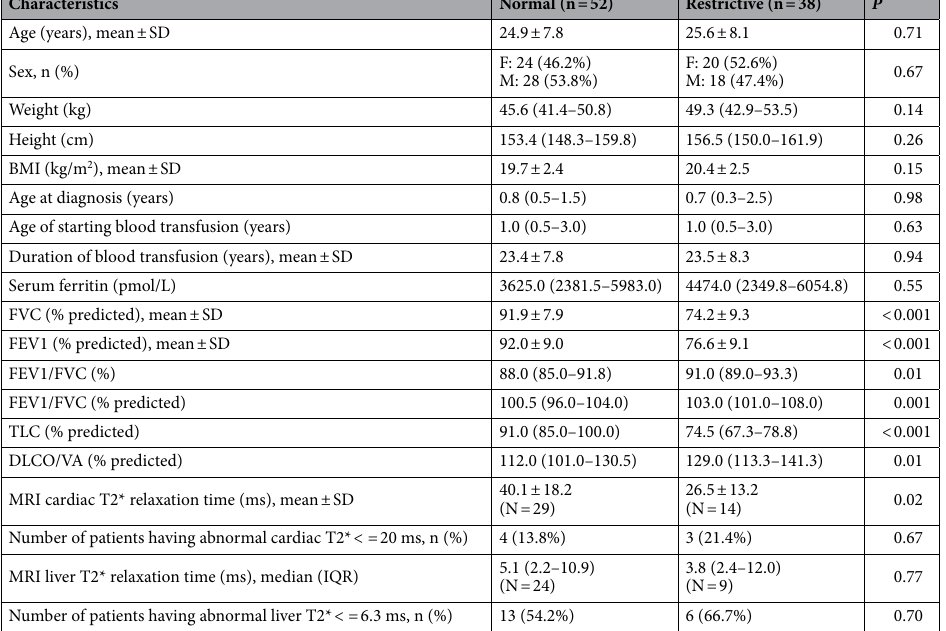
Table 2. Comparisons of clinical characteristics between participants with normal lung function and those with restrictive lung disease. Values are presented as medial and interquartile range (IQR) unless otherwise specified. P values by t-test, Mann–Whitney U and chi-square test for parametric, non-parametric, and categorical variables respectively. BMI, body mass index; SD, standard deviation; FVC, forced vital capacity;